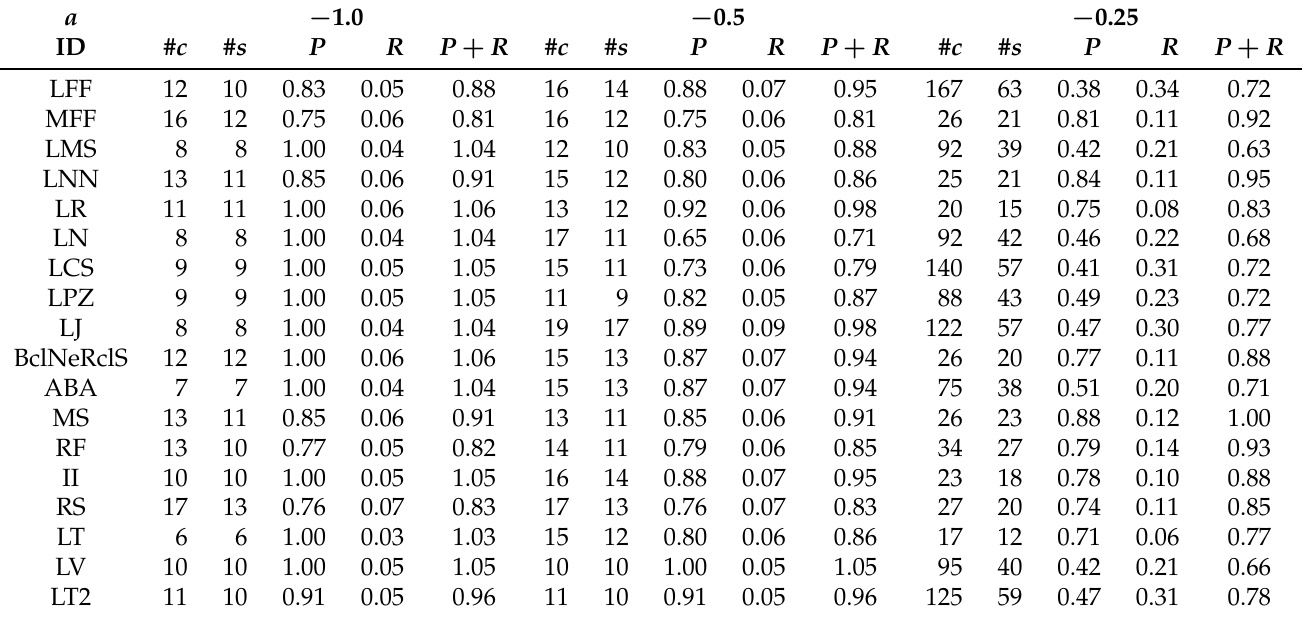
Table 9. Performance of cutoff assessment on single Squinzanese texts.